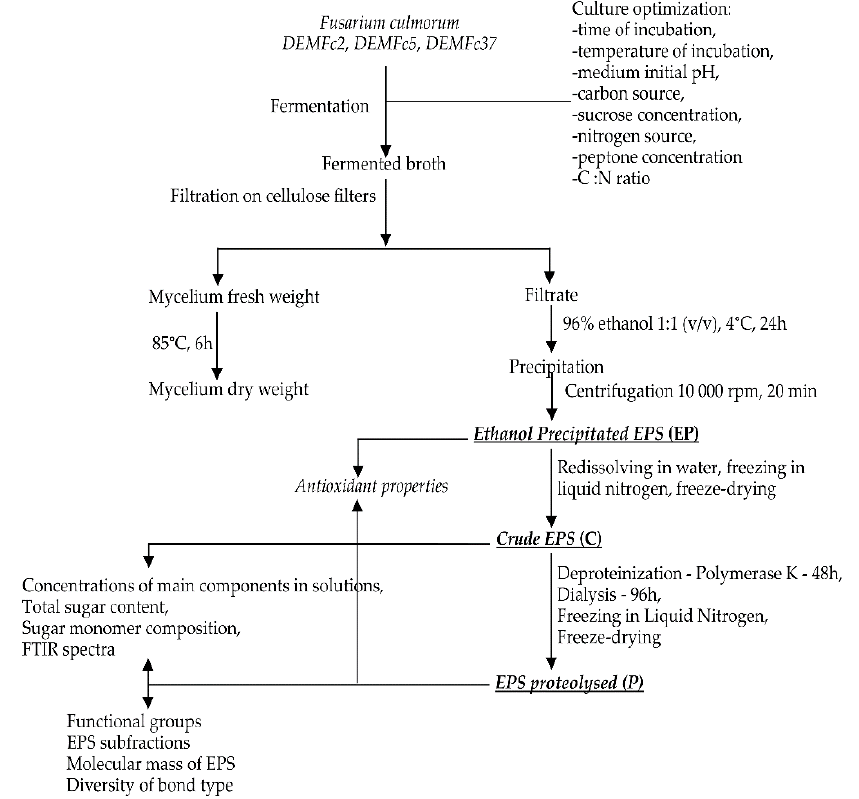
Figure 1. Scheme for the procedure of isolation and fractionation of EPS from liquid cultures of the three Fusarium culmorum strains (DEMFc2, DEMFc5 and DEMFc37) in three forms: Ethanol Precipitated (EP) , Crude (C) , and Proteolysed EPS (P) and the protocol for studies of EPS properties.